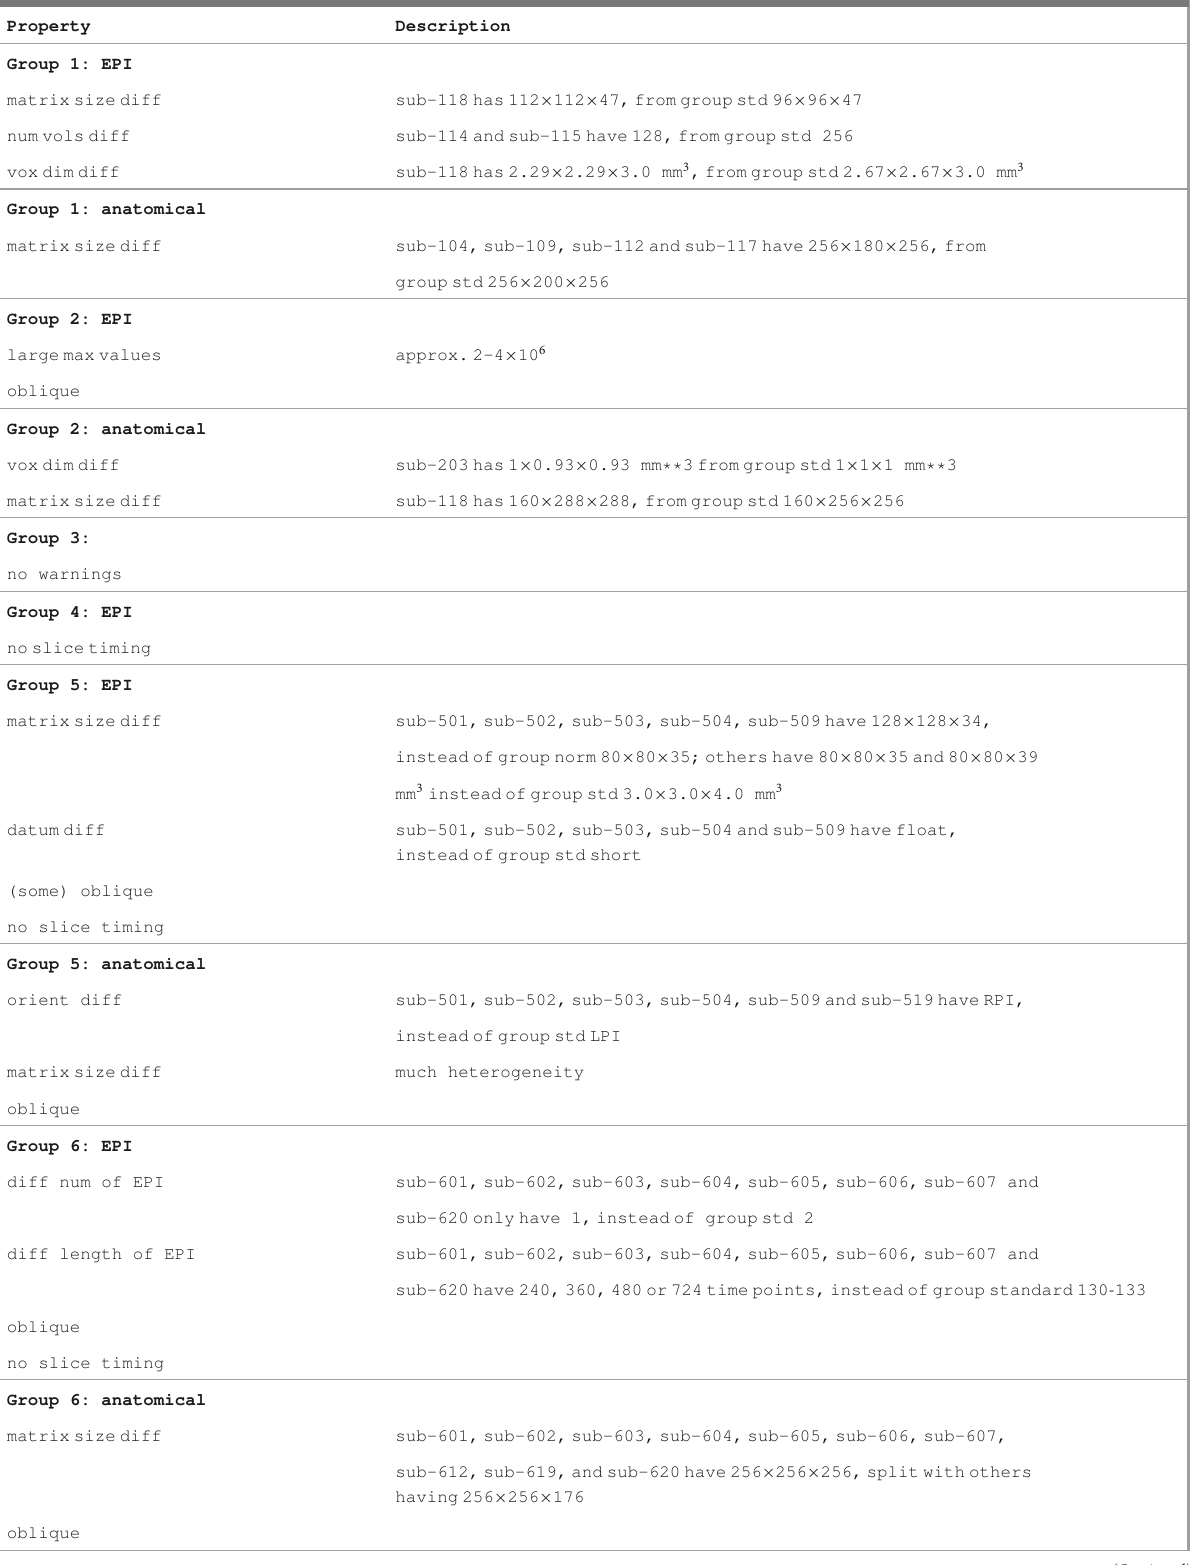
TABLE 2 Summary of the first stage of resting state FMRI QC: GTKYD (“getting to know your data”). GTKYD: “Getting To Know Your Data” results (resting state